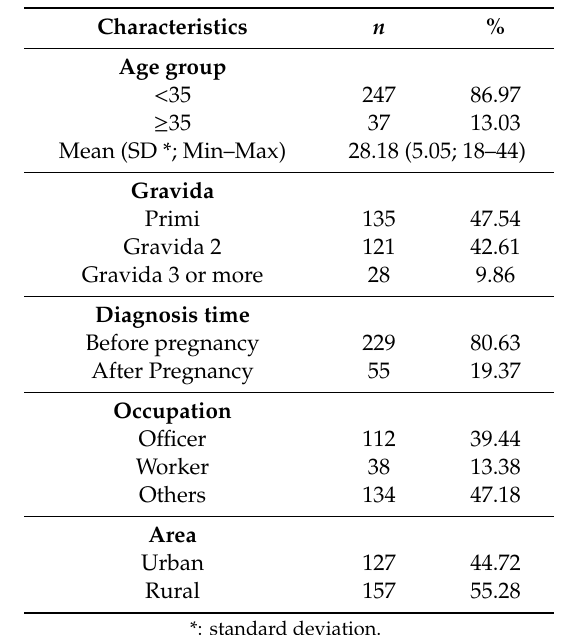
Table 1. Some selected characteristics of study patients ( n = 284).